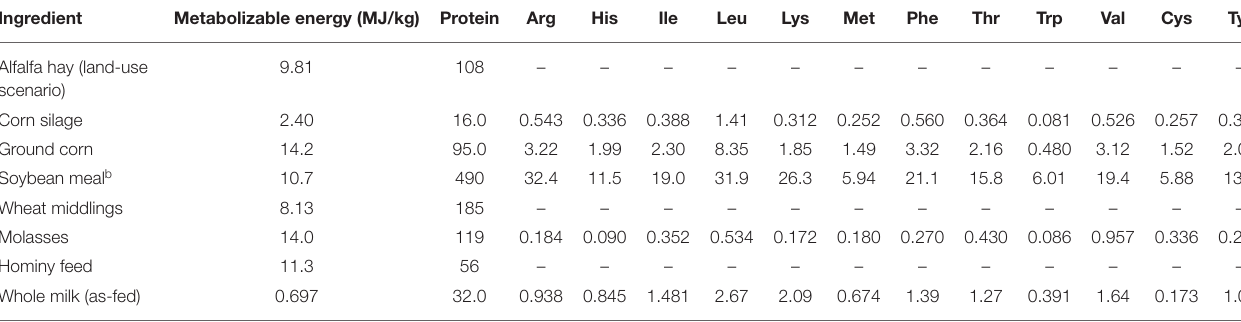
TABLE 5 | Human-edible (HE) nutrient values used for calculations (DM basis; g/kg unless otherwise labeled) a . Ingredient Metabolizable energy (MJ/kg) Protein